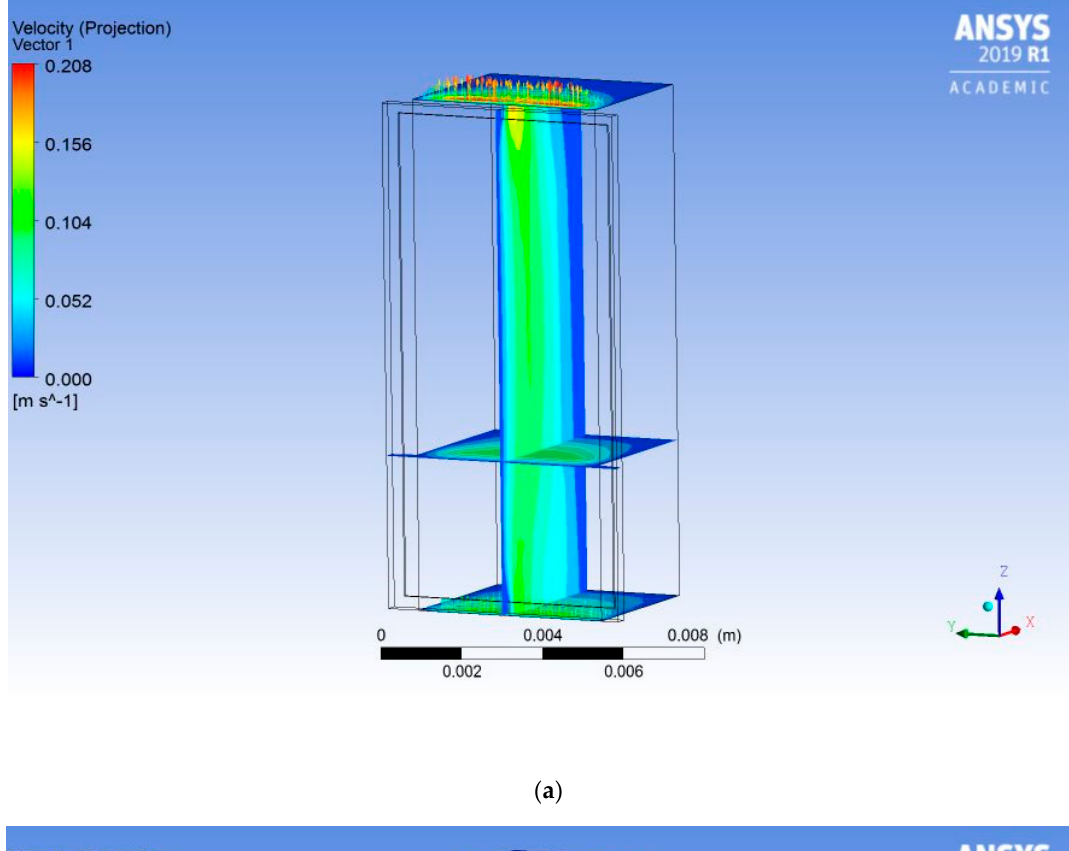
Figure 3. Comparison between the experimental and simulated results of velocity.